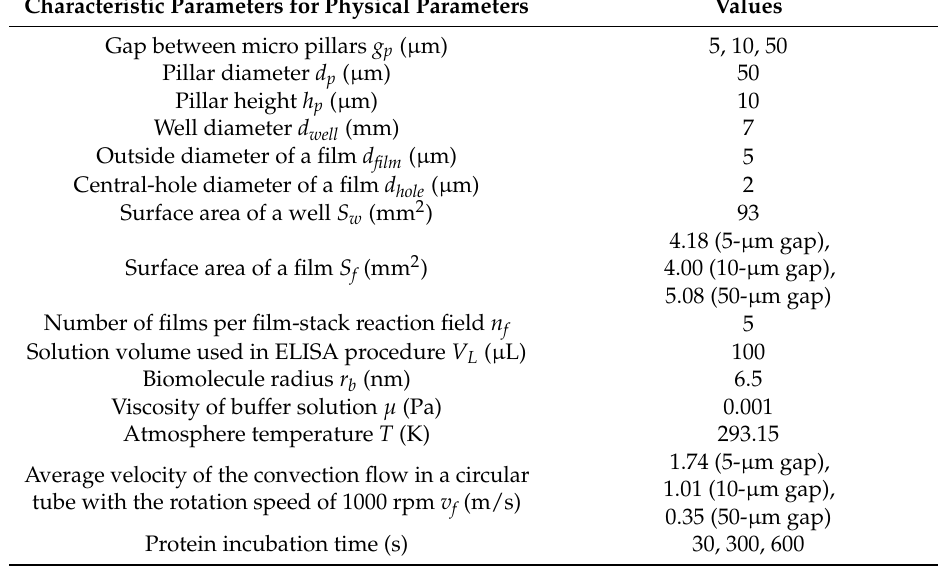
Table 2. Conditions for the calculation of physical parameters in the theoretical